Question: What caption would you write for this figure?
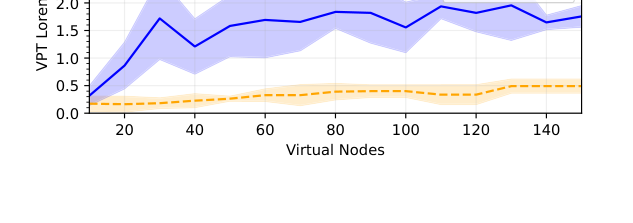
Answer: (a) NRMSE, (b) VPT for UCTLS, and (c) VPT for ALRS for classical linear regression (dashed orange line) and attention- enhanced reservoir computing (solid blue line) with varying coupling strength reservoir sizes N. The shaded areas depict the standard de- viations of NRMSE and VPT over ten time series.